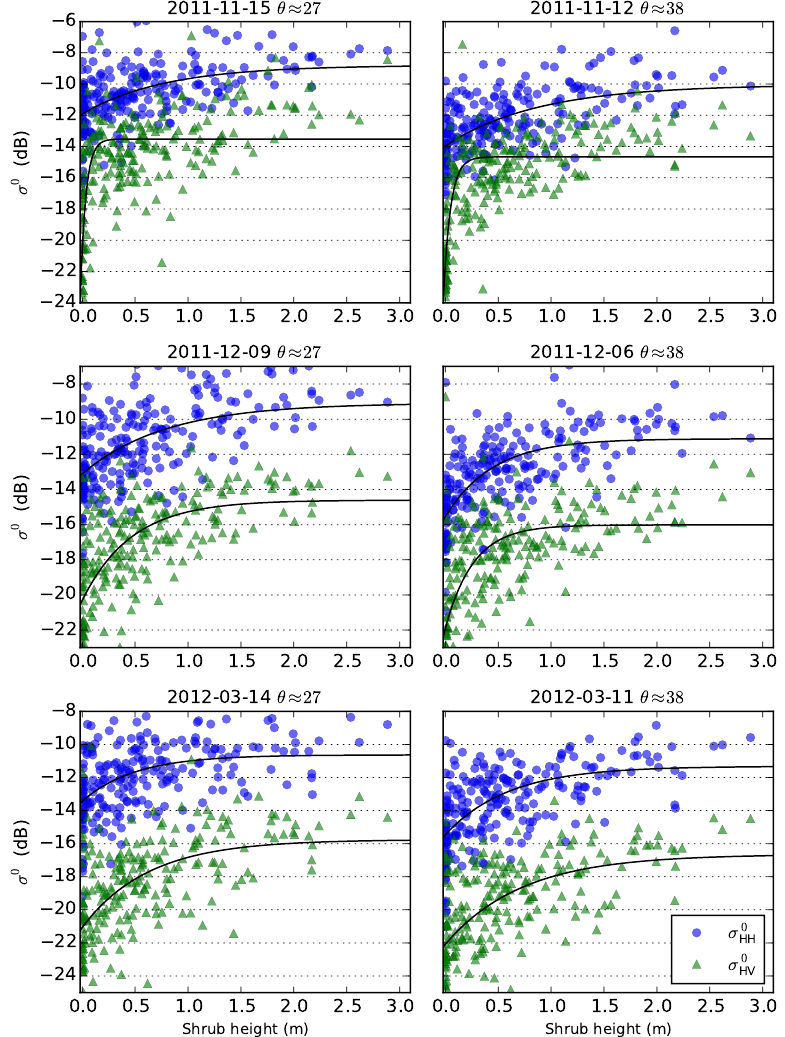
Figure 8. σ 0 as a function of vegetation height for RADARSAT-2 acquisitions for November 2011, December 2011 and March 2012 at θ ≈ 27 ◦ ( left ) and θ ≈ 38 ◦ ( right ) incidence angles. The blue circles represent HH polarization, and the green triangles represent HV polarization. The black lines are the best fit results for the